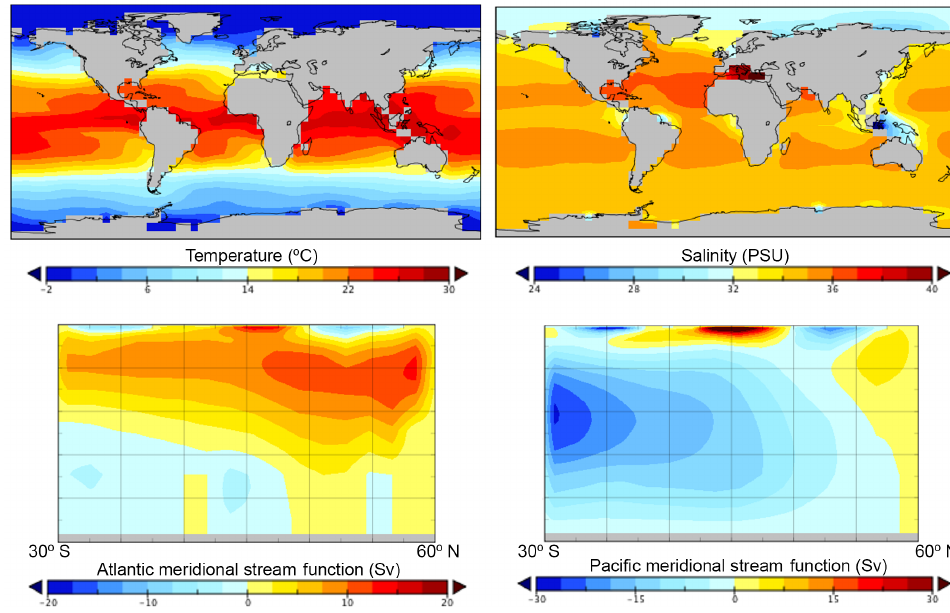
Figure 6. Ocean. Upper panels: PLASIM–GENIE simulated surface ocean temperature and salinity; lower panels: PLASIM–GENIE simu- lated Atlantic and Pacific meridional stream functions.